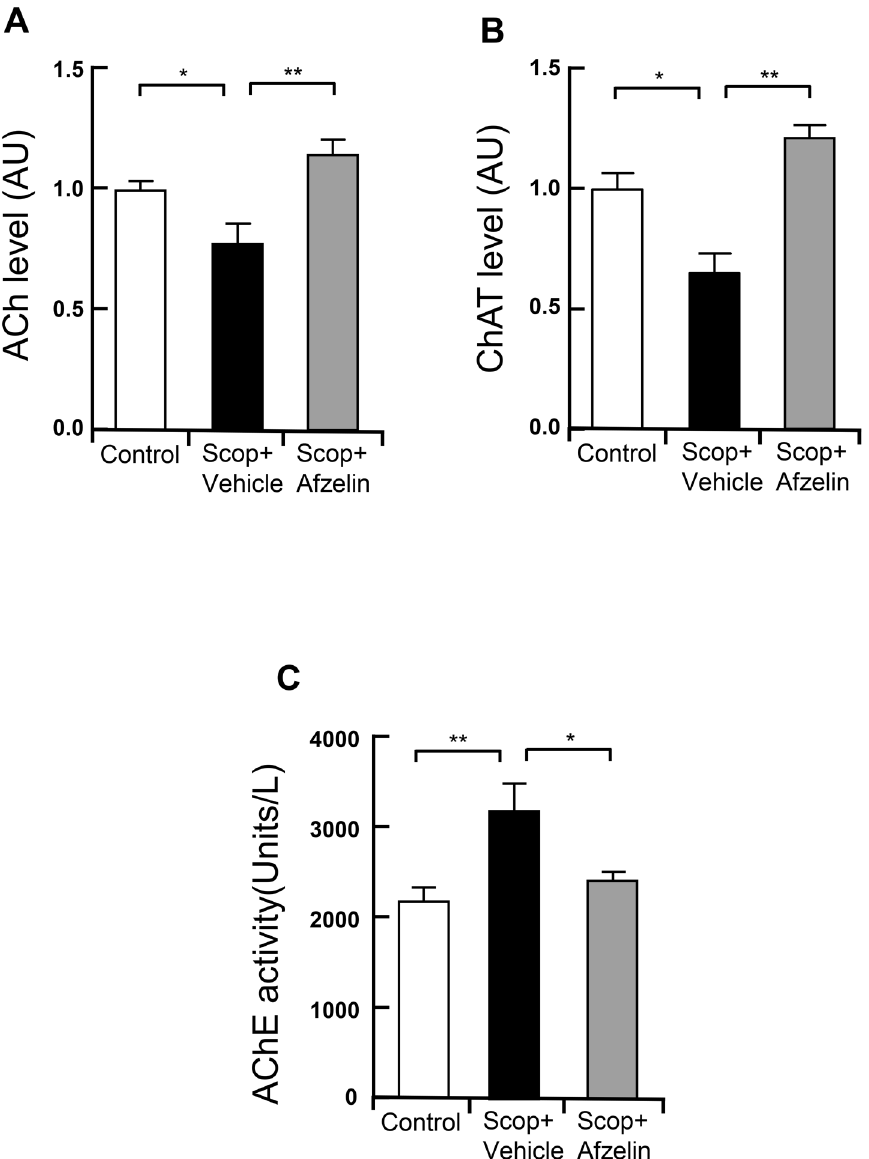
Figure 4. Effect of afzelin on cholinergic function in the hippocampus. Standard C57BL/6 mice (4 weeks old) were pre-treated into third-ventricle of brains cannula with 100 ng/µl of Afzelin (0.5 µl) or PBS (0.5 µl) for one month. The mice were received with scopolamine (Scop) injection (i.p. 0.8 mg/kg) for the behavior tests then hippocampi of these mice were collected for measuring cholinergic changes. ( A – C ) Acetylcholin (ACh) levels ( A ), Choline acetyltransferase (ChAT) level ( B ), Acetylcholinesterase (AChE) activity ( C ) in the hippocampus were measured in hippocampi of the control (PBS as a vehicle), scopolamine + vehicle (Scop + vehicle, PBS as a vehicle) and scopolamine + Afzelin (Scop + Afzelin, 100 ng/µl afzelin of pretreatments) groups *p < 0.05, **p < 0.01; one-way ANOVA with Tukey’s post hoc test ( A – C ); n = 3–4 mice for Acetylcholine (ACh) levels ( A ), n = 3 mice for Choline acetyltransferase (ChAT) level ( B ), n = 4–6 for Acetylcholinesterase (AChE) activity ( C ). Data are mean ±